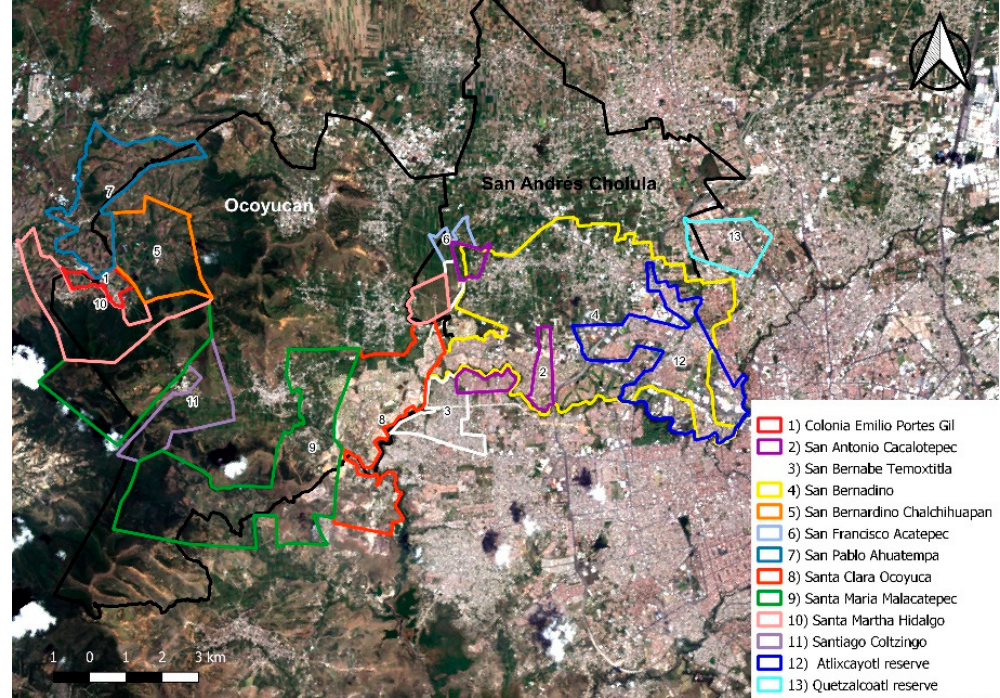
Figure 2. Distribution of Ejidos in San Andrés Cholula and Santa Clara Ocoyucan.